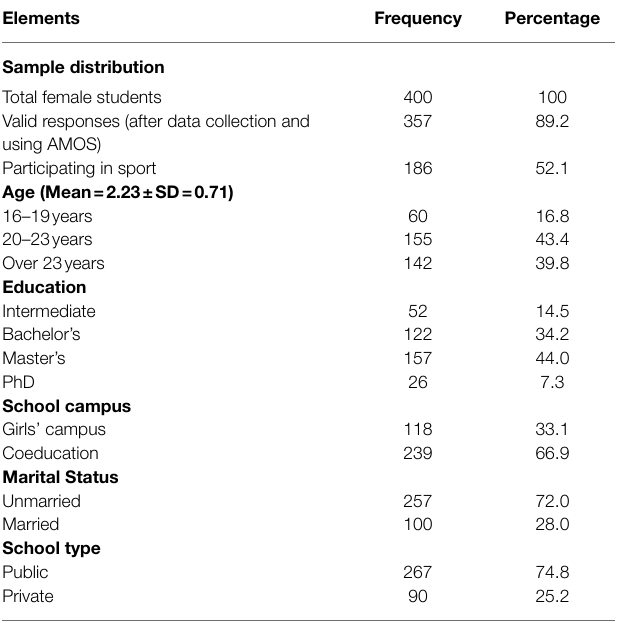
TABLE 1 | Background information of the participants.